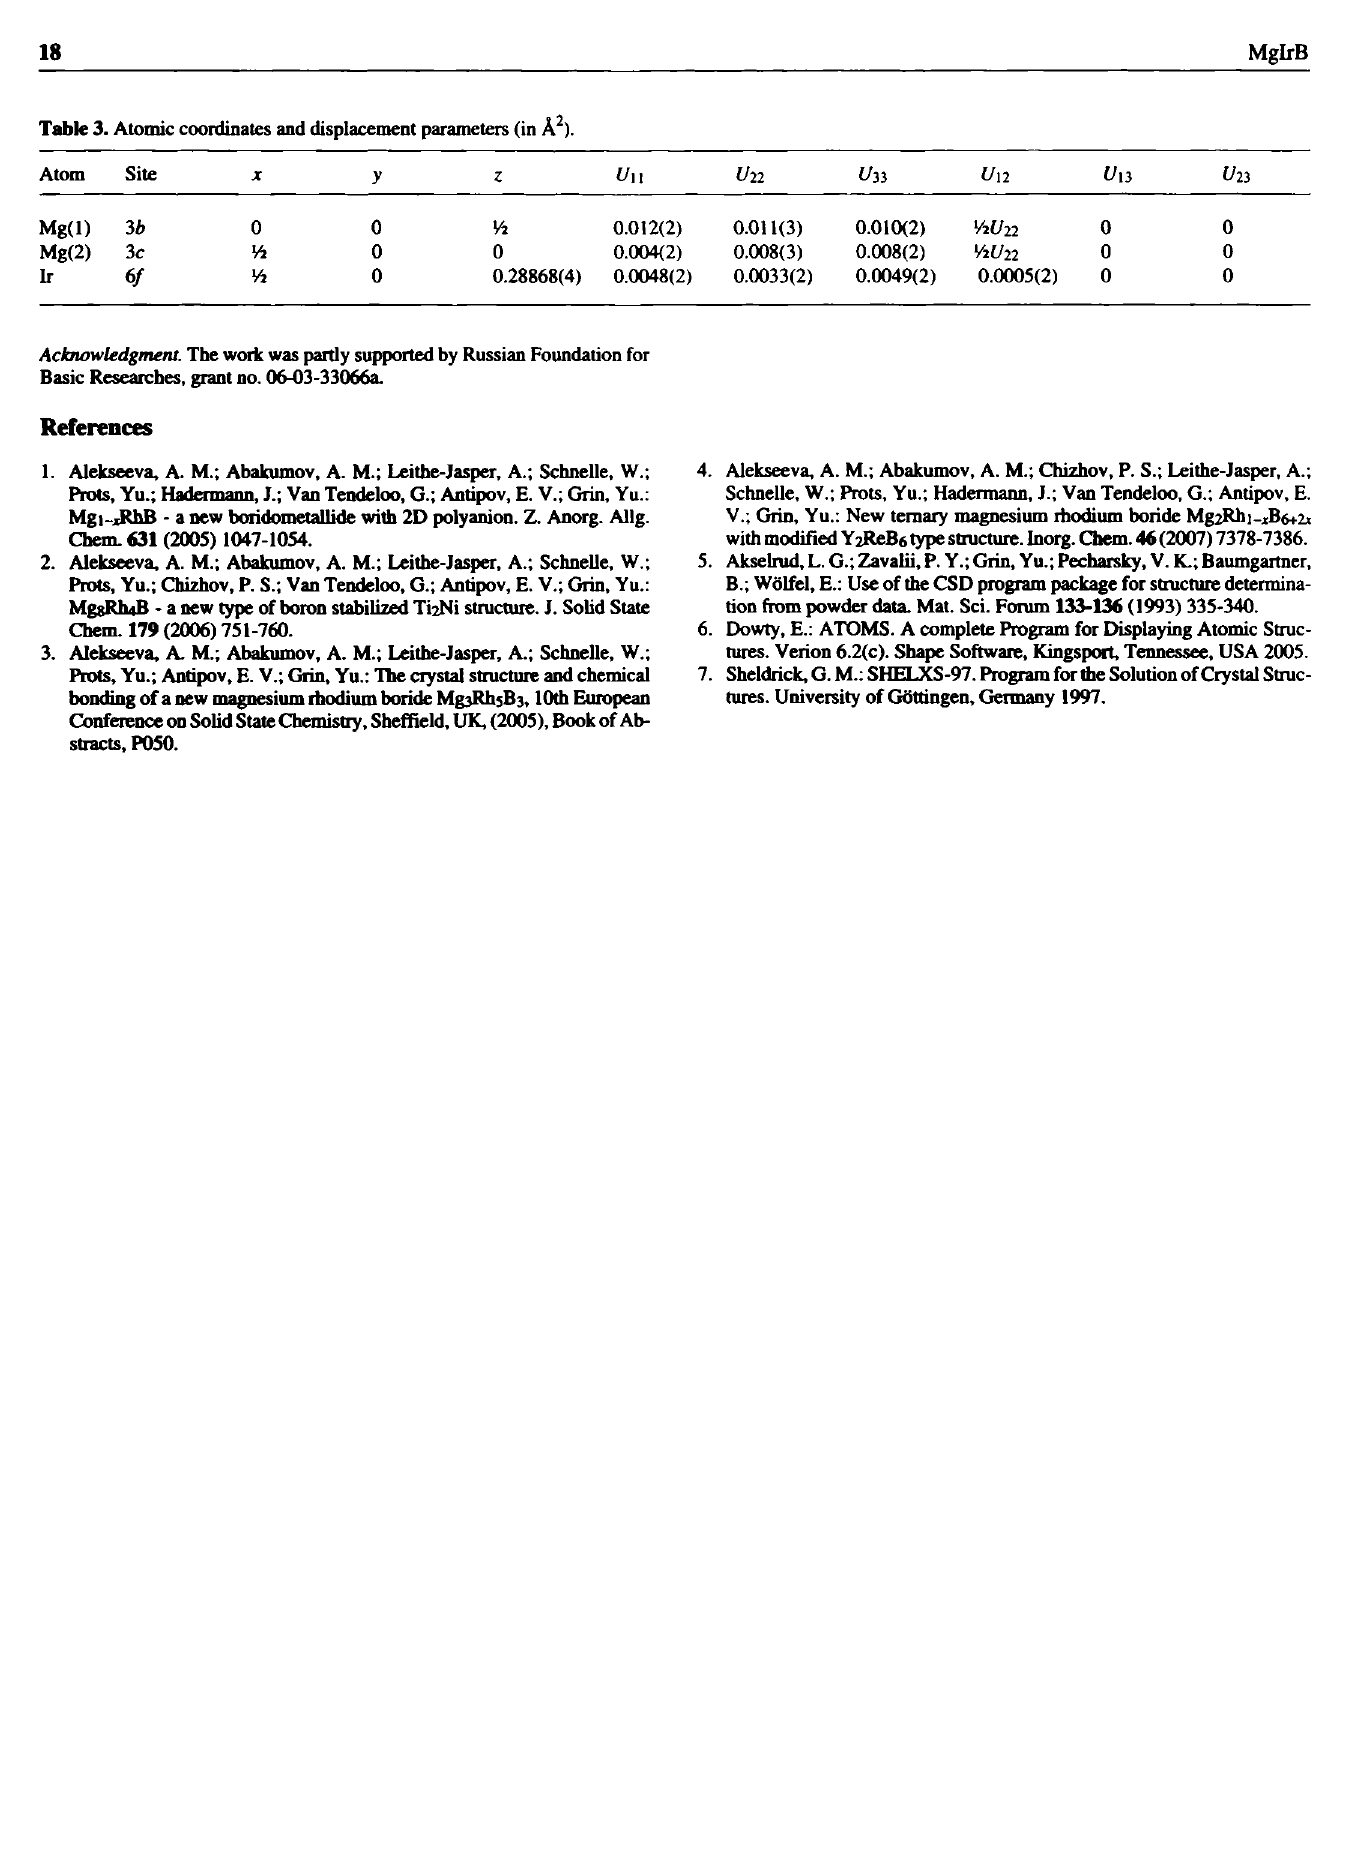
Table 3. Atomic coordinates and displacement parameters (in Â 2